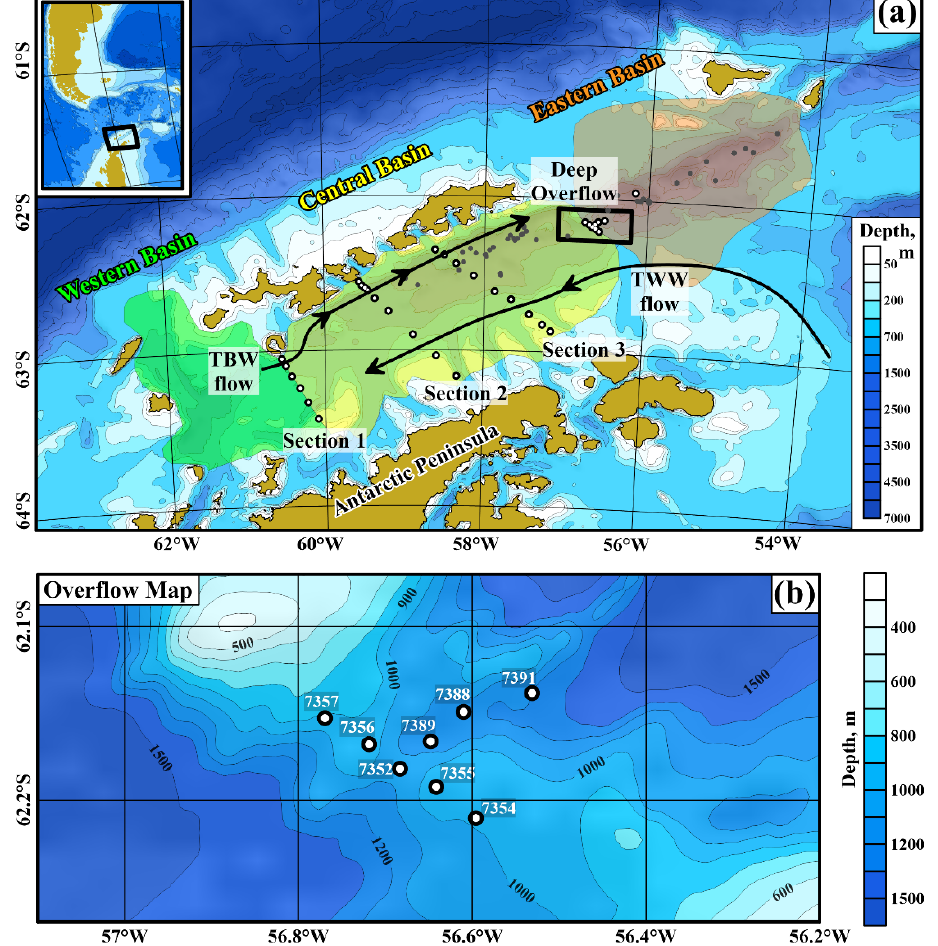
Figure 1. ( a ) Bathymetry of the Bransfield Strait and ( b ) the region of the overflow between the central and eastern basins. ( a ) The upper layer circulation schematic is shown by black arrows. Western, central, and eastern basins of the strait are shown with green, yellow, and orange, respectively. CTD/LADCP stations performed in 2022 are shown by white dots; historical CTD stations from World Ocean Database (WOD2018) used in this study are shown by grey dots. The bottom relief is shown according to the GEBCO2021 database; the shoreline is based on the GSHHS data [17]. Station 7390 (not shown) repeats station